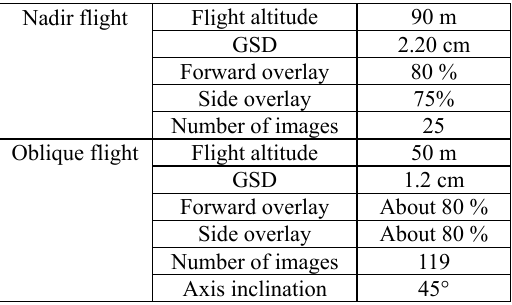
Table 3: Number of points in the 3D model